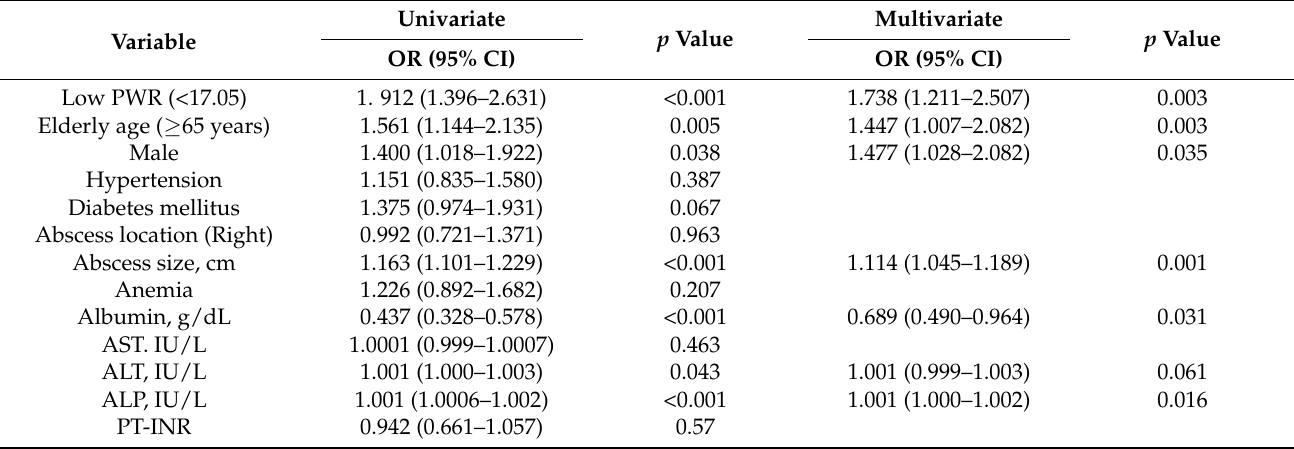
Table 6. Risk factors for prolonged hospitalization for more than 28 days in patients with pyogenic liver